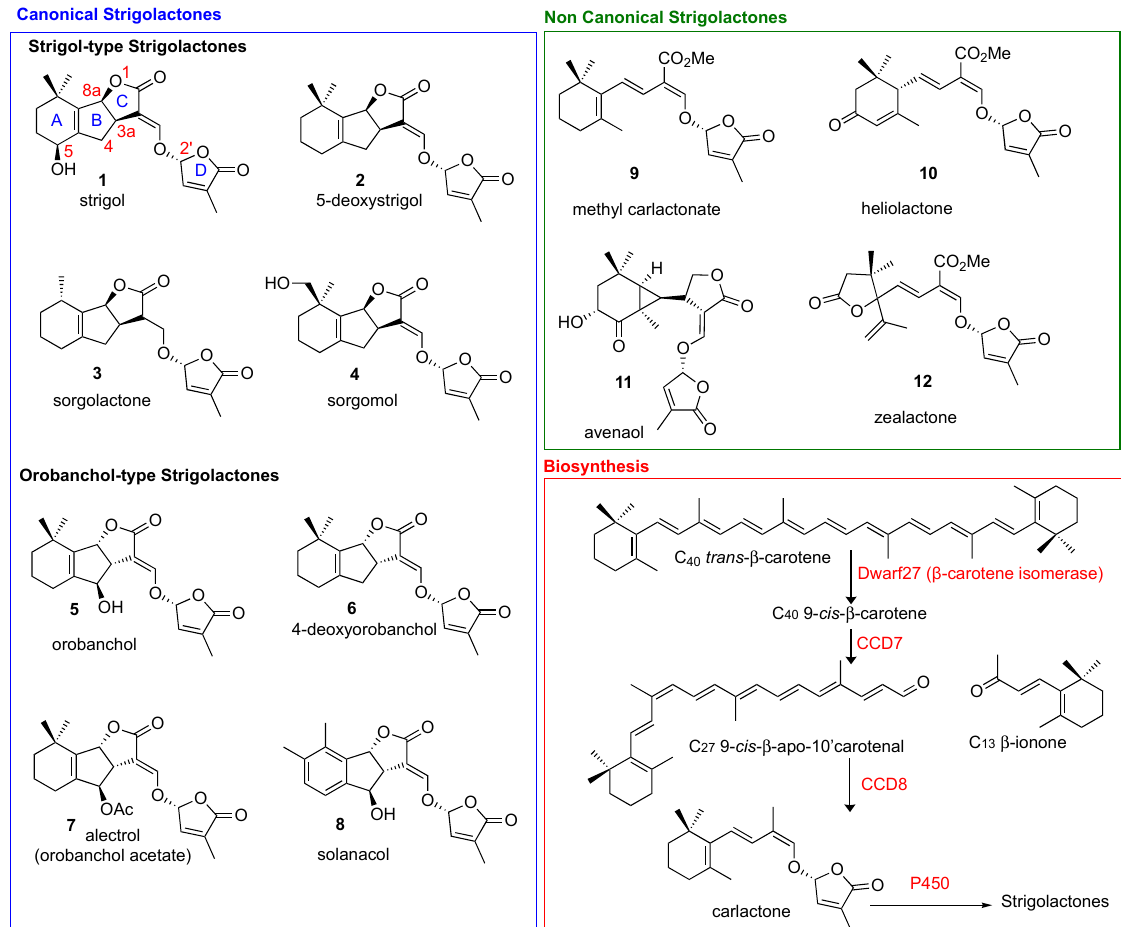
Figure 1. Structural diversity of natural canonical (blue box) and non-canonical SLs (green box). Biosynthesis in red box.